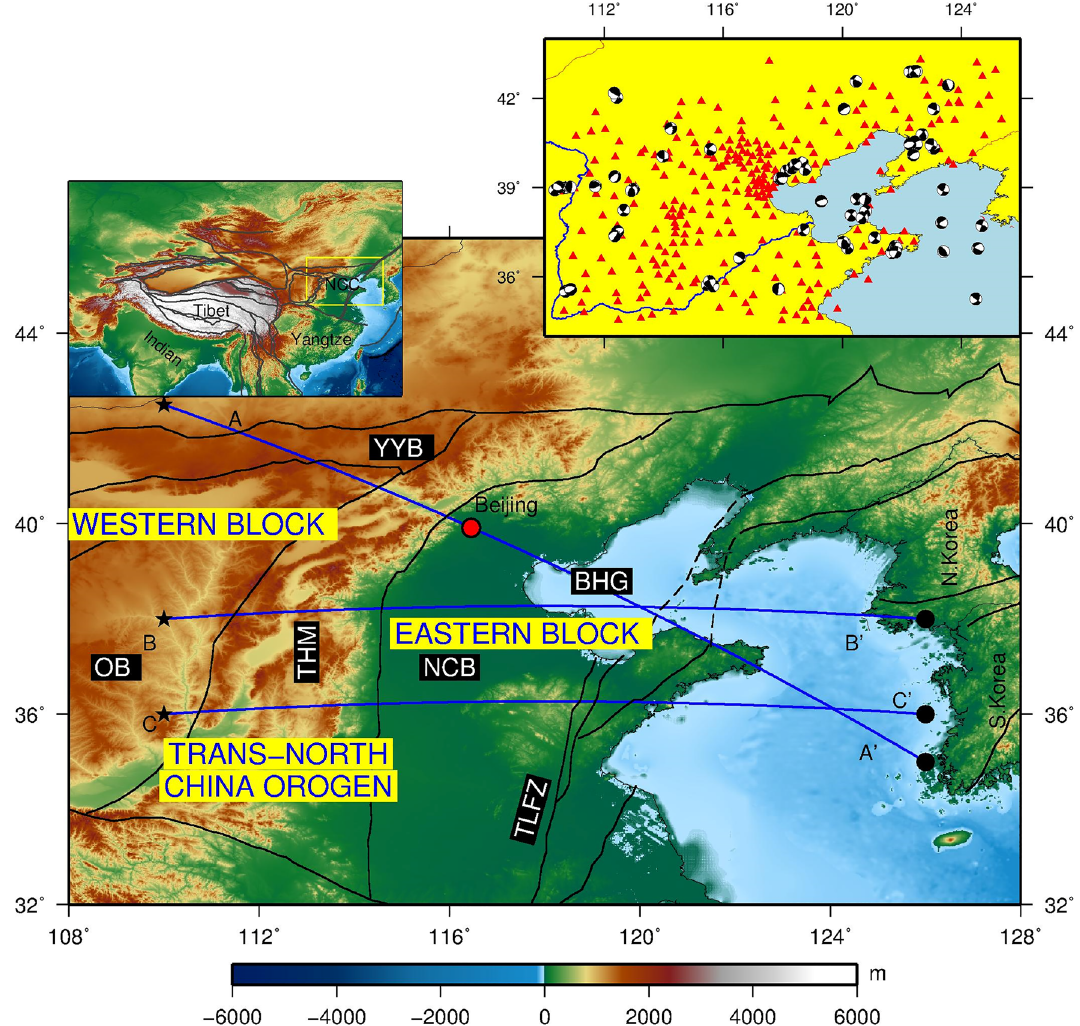
Figure 1. Geological and topographic map of the North China Craton. Blue lines A–A ′ , B–B ′ and C–C ′ indicate the location of three vertical profiles. YYB: Yinshan-Yanshan Block; OB: Ordos Block; THM: Taihang Mountains; NCB: North China Basin; BHG: Bohai Gulf; TLFZ: Tan-Lu Fault Zone. The left inset shows the location of the NCC in East Asia; the right inset shows the focal mechanisms of earthquakes (beach balls) and seismic stations (red triangles) in the study. The map in the figure was generated by the Generic Mapping Tools package 115 (GMT-4.5.9, https:// www. gener ic- mappi ng- tools.